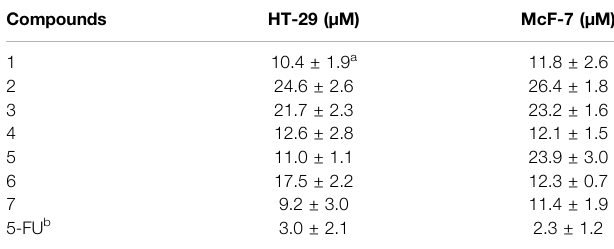
TABLE 3 | Cytotoxicity of compounds 1 – 7 against HT-29 and McF-7 cancer cell